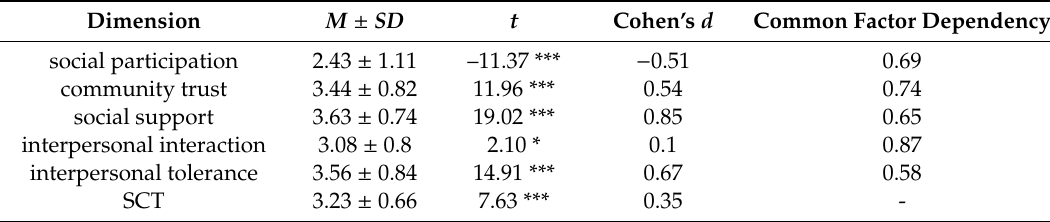
Table 4. Social capital theory (SCT) dimension scores ( n =